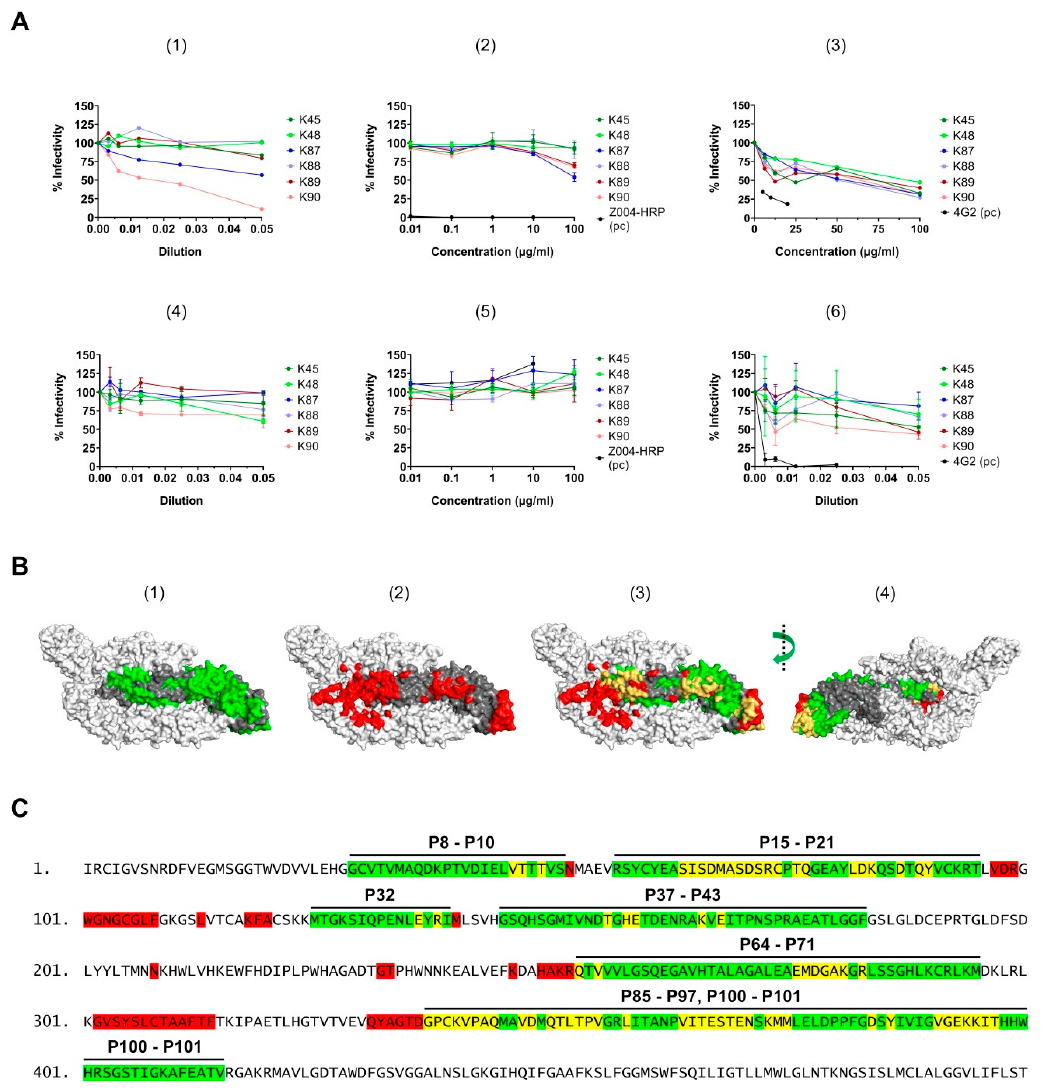
Figure 9. Correlation between the neutralizing activity and the binding sites. ( A ) Serial dilution of the sera (in 1, 4, and 6) or the purified antibodies (in 2, 3, and 5) was incubated with the Asian strain (in 1, 2, and 6) or the African strain (in 3) of ZIKV, or with WNV (in 4 and 5). The serum/purified antibody-virus mixture was used to infect Vero cells (in case of ZIKV) or Vero E6 cells (in case of WNV). The neutralizing antibody 4G2 or Z004-HRP (anti-ZIKV E Domain 3, Absolute antibody) were used as controls, however, failed to neutralize WNV. For quantification, the results are presented as % infectivity, and the number of plaques in the control sample, where the virus was applied without previous mixing with serum, was set as 100% infectivity. Data are represented as mean ± SEM. The dilution fold of the serum (in 1, 4, and 6) and the antibody concentration (µg/mL, in 2, 3, and 5) are indicated in each case. The serum was applied either with (in 1) or without (in 4 and 6) heat-inactivation. The results were collected from two independent experiments, except for Uganda (in 3) and Polynesia (in 1) from one experiment; ( B ) (1) All binding sites, which were marked in Figure 7, are shown here in green color on a single ZIKV E molecule. (2) Footprints of 14 ZIKV neutralizing antibodies are shown in red on the surface representation of ZIKV E protein. The